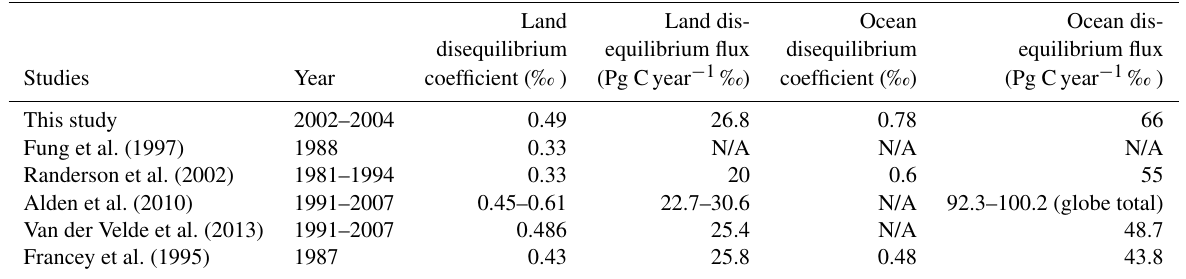
Table 5. Global isotopic mass budgets averaged for the 2002–2004 period for the prior, double deconvolution, CO 2 -only inversion, and joint